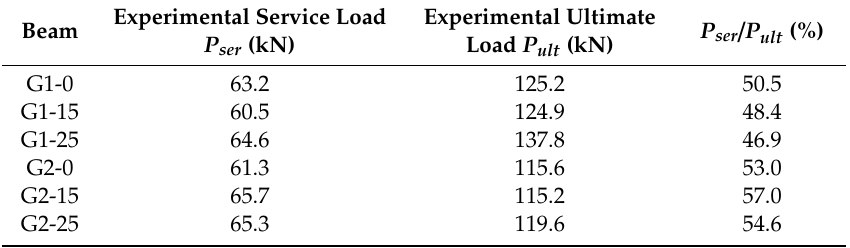
Table 4. Experimental service load for tested beams at which midspan deflection reaches L / 240.